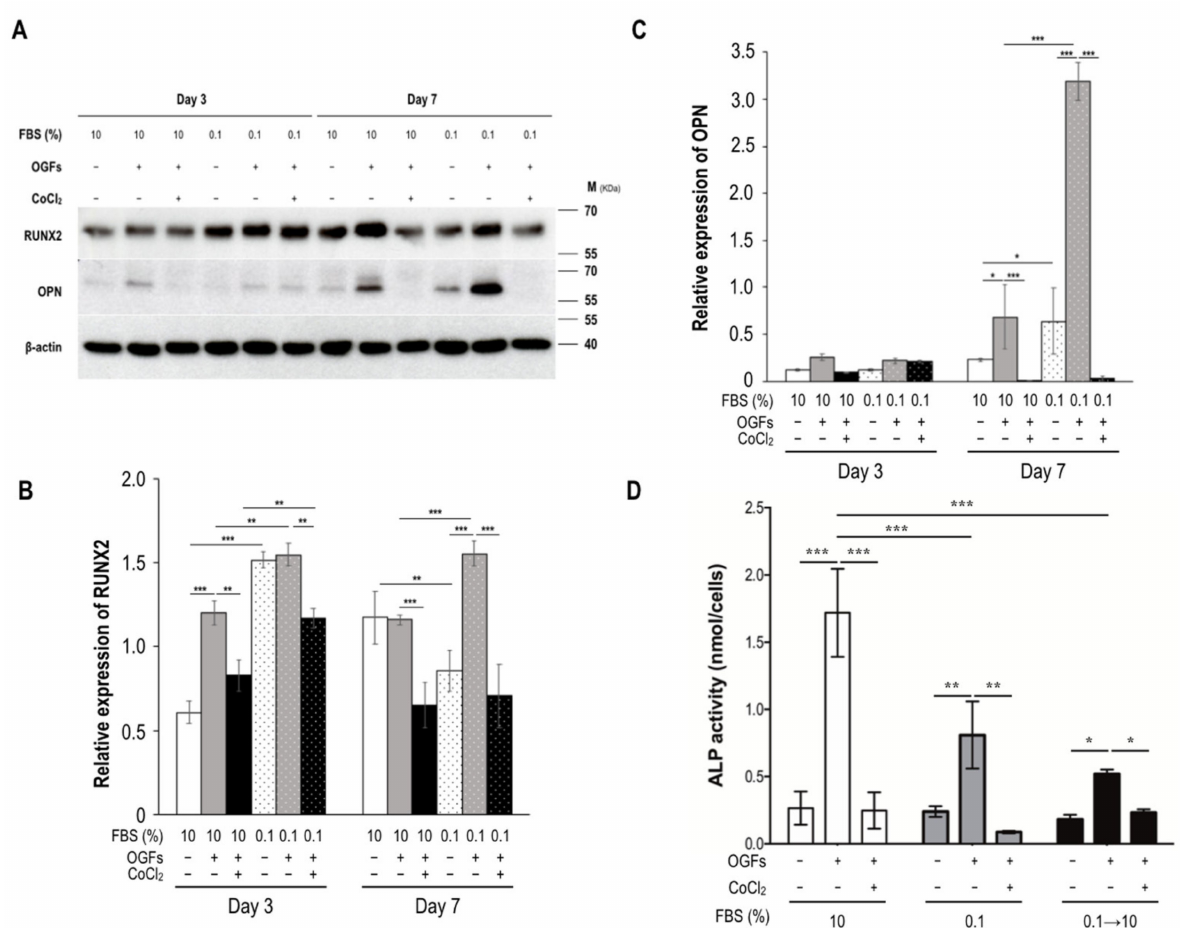
Figure 6. Expression patterns of osteoblast markers under the stress of serum insufficiency alone or in combination with hypoxia. ( A ) Immunoblotting was used to detect marker proteins in MC3T3-E1 cells after different treatments. Anti-RUNX2 and OPN antibodies were used to detect osteoblast markers. ( B – D ) All data are presented as mean ± SD ( n = 3); asterisks at the tops of bars indicate significant differences (* p < 0.05, ** p < 0.01, *** p < 0.001). Quantification of ( B ) RUNX2 and ( C ) OPN expression levels. Identities of RUNX2 and OPN were normalized to that of the level of β -actin. ( D ) Serum reperfusion had no effect on ALP activity. Abbreviations: FBS, fetal bovine serum; M, marker; OGF, osteogenic growth factor; OPN, osteopontin; RUNX2, runt-related transcription factor